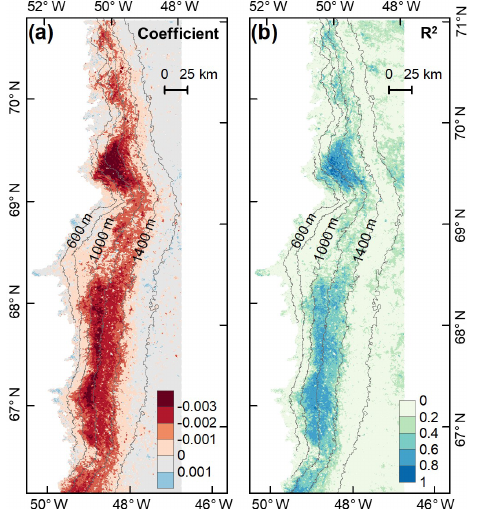
Figure 9. Temporal trends in MODIS broadband albedo during July and August (over 2004–2011). (a) Regression coefficients of sur- face albedo with time (d) from 1 July to 20 August. (b) Correspond- ing R 2